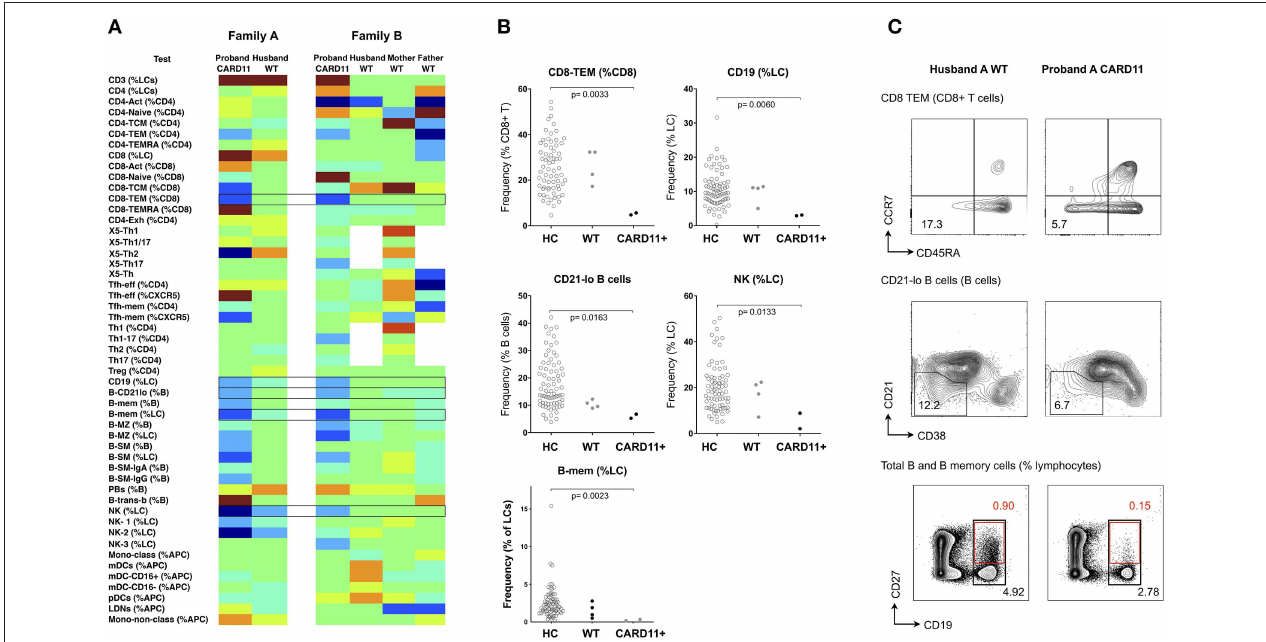
FIGURE 6 | Analysis of cellular parameters in a CARD11 mutant kindred. (A) Heat mapping with discontinuous shading showing changes in cell populations for two unrelated patients with dominant negative CARD11 mutations, along with their relative(s) without mutation. Boxes highlight cellular changes common to the two CARD11 mutants, but differing from the family members. (B) Scatter plots showing raw values for populations identified in (A) , along with representative FCM contour plots of these critical parameters (C) ; in the B-cell contour plot, black boxes and numbers refer to total CD19 + cells, and red boxes and numbers refer to CD19 + /CD27 + memory B cells. Raw and centile data is presented in Supplementary Table 3